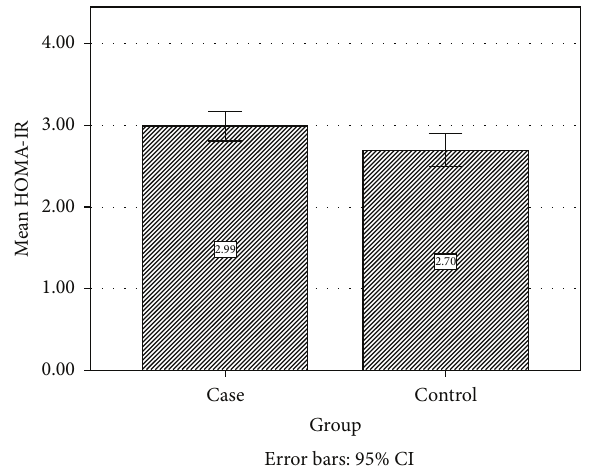
Figure 3: Comparison of HOMA-IR in case and control